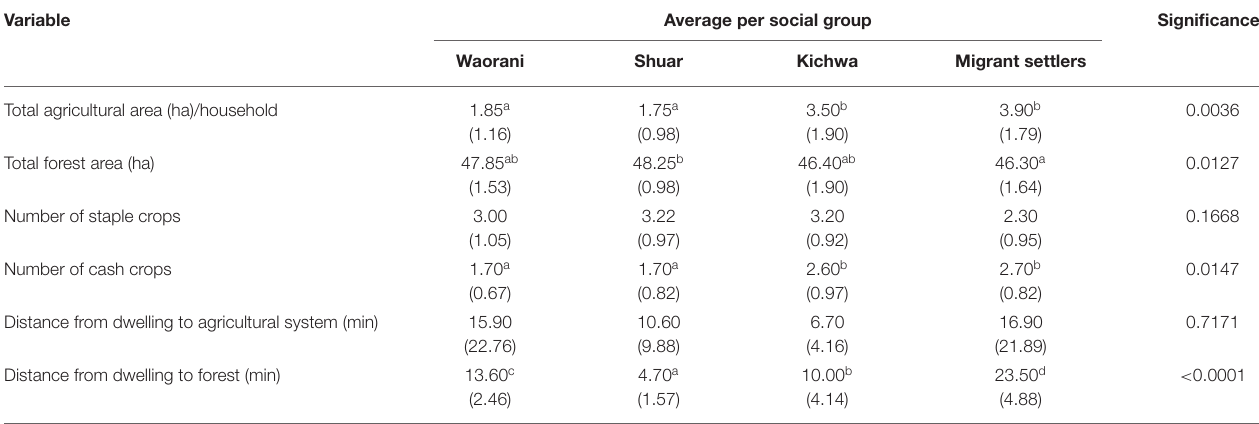
TABLE 5 | Agricultural variables (mean and standard deviation in parentheses) of the traditional productive systems of the Waorani, Shuar, Kichwa indigenous peoples and migrant settlers in the Yasuní Biosphere Reserve, Amazon Region of Ecuador.